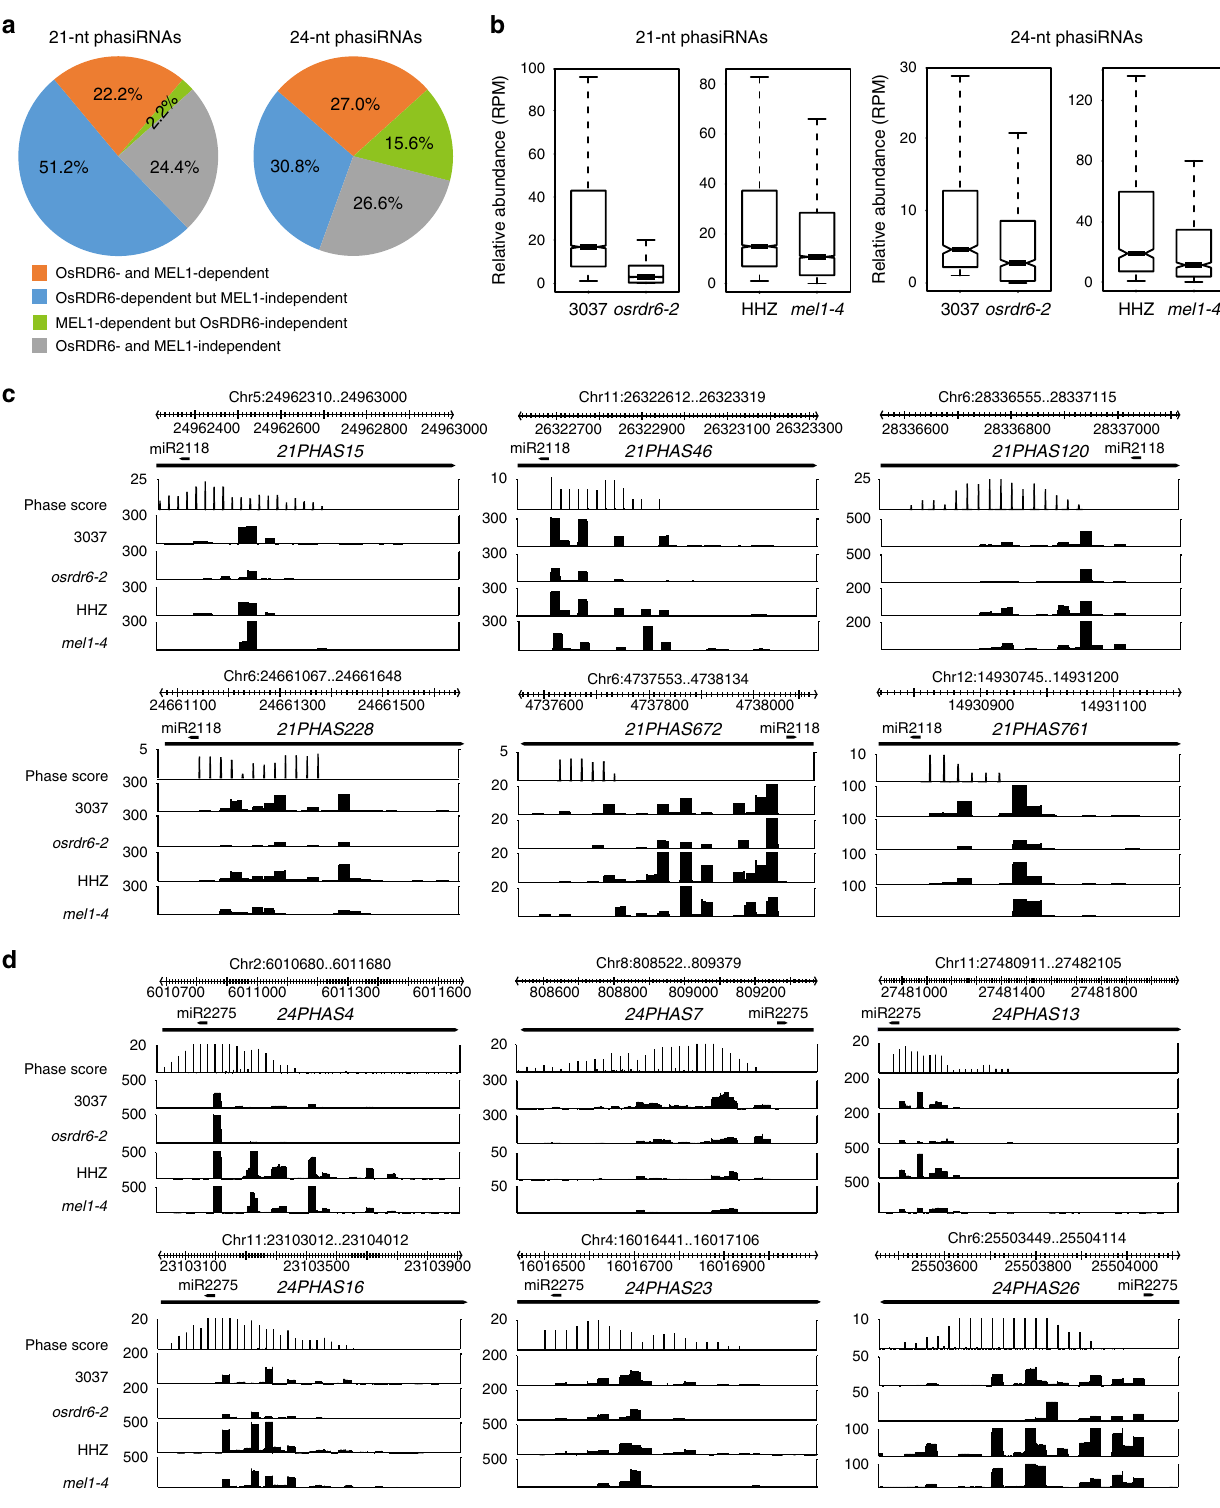
Fig. 2 PhasiRNA accumulation in early prophase I meiocytes is largely dependent on OsRDR6 and MEL1. a Pie charts showing the percentages of phasiRNAs whose accumulation is dependent or independent on OsRDR6 or MEL1. b Boxplots showing the relative abundances of 21- and 24-nt phasiRNAs in prophase I meiocytes of the osrdr6-2 and mel1-4 mutants and their respective wild-type plants. The central line of the box represents the median while two bounds represent 25% quartile and 75% quartile, respectively. The whisker represents 1.5× interquartile range of the lower or upper quartile. c , d Genome browser views of phasiRNA signals at the indicated 21- c and 24-nt d PHAS loci in early prophase I meiocytes of the osrdr6-2 and mel1-4 mutants and their respective wild-type